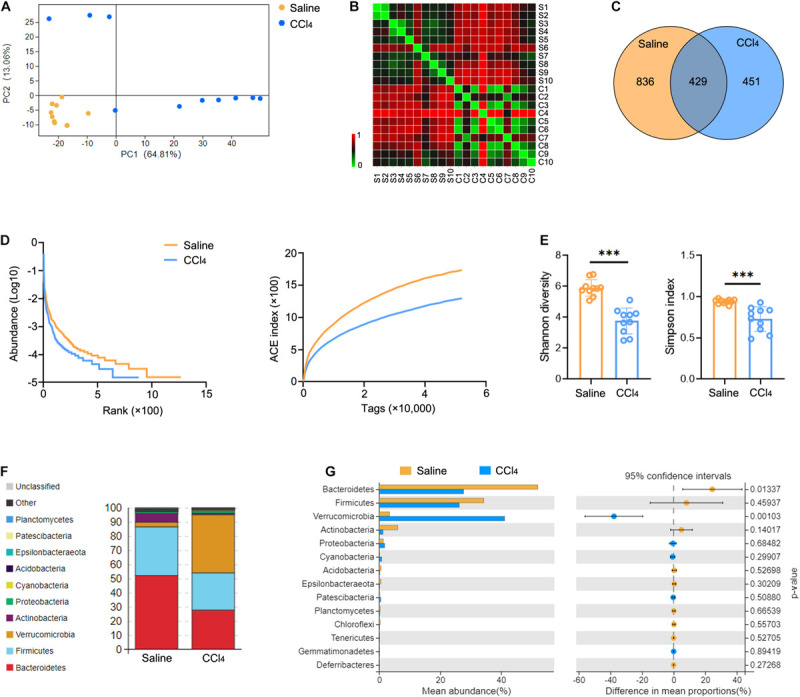
Liver fibrosis influences GM community and diversity. WT mice were treated three times weekly with CCl4 or 0.9% saline for 8 weeks. The 16S rRNA-seq data from cecal content were evaluated (N = 10). (A,B) Beta diversity determined by PCA (A) and Bray-Curtis distance (B), showing closeness and distance between the two groups. (C) Venn analysis was performed to identify unique and common OTUs. (D,E) Alpha diversity determined by rank-abundance (left), ACE curve (right) (D), Shannon diversity (left), and the Simpson index (right) (E) were used to measure the diversity of GM. (F,G) The composition (F) and abundance (G) of GM at the phylum taxonomic level. ***P < 0.001.